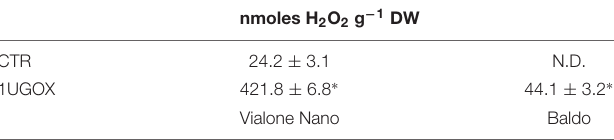
TABLE 1 | Extracellular H 2 O 2 content after treatment with glucose/GOX.